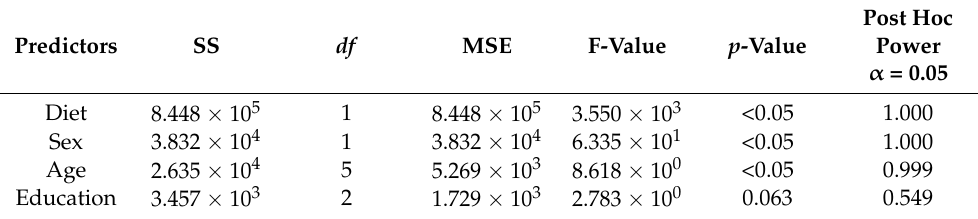
Table 2. Statistical significance of predictors of covariance models for changes in the average weekly coverage of demand for iodine.